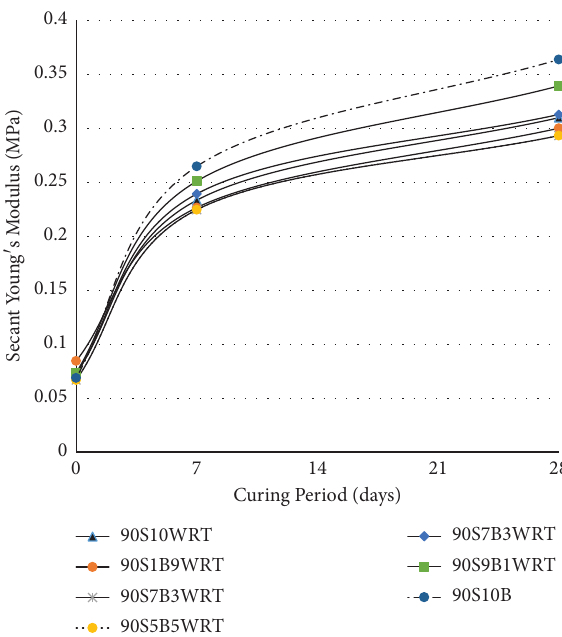
Figure 5: Secant Young’s modulus versus curing period.